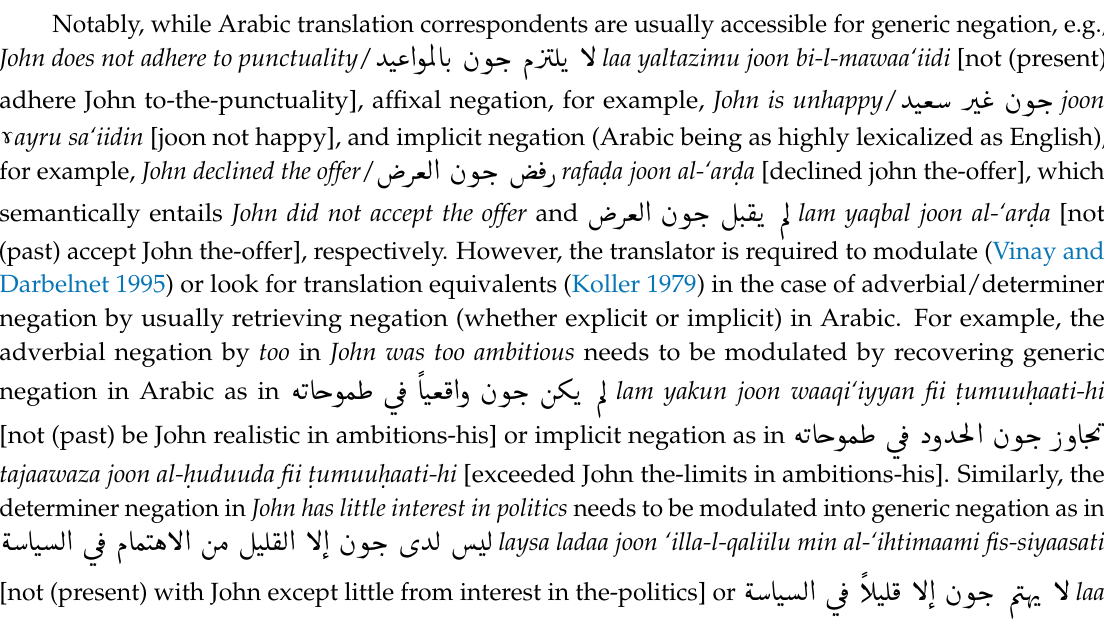
Table 4. Frequency and percentage of translation strategies in rendering -ly